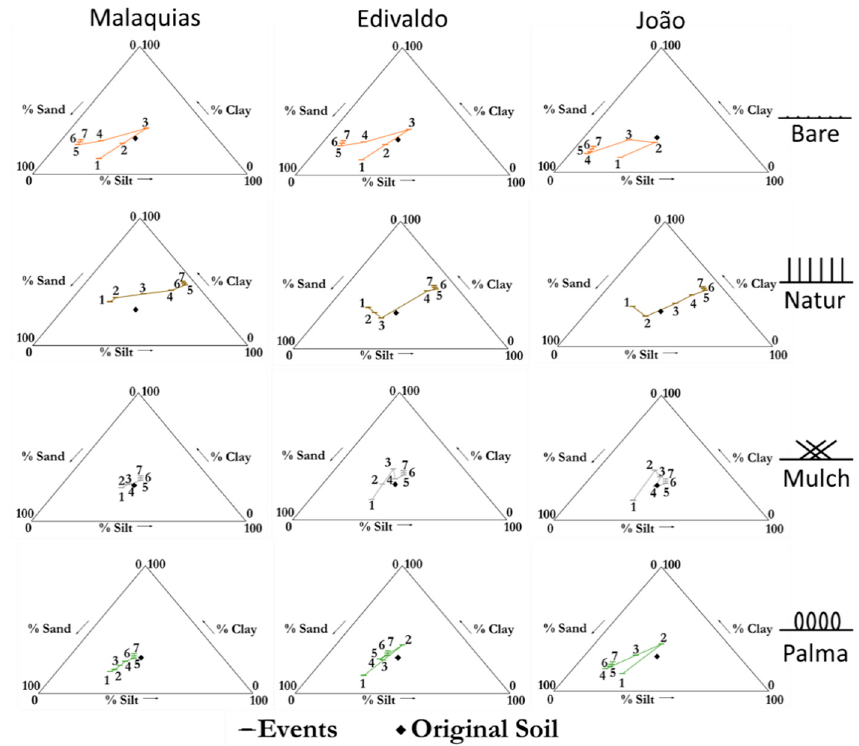
Figure 12. Evolution of sand, silt, and clay percentages during the hydrology year 2016 / 2017, for all runo ff events and studied plot covers.